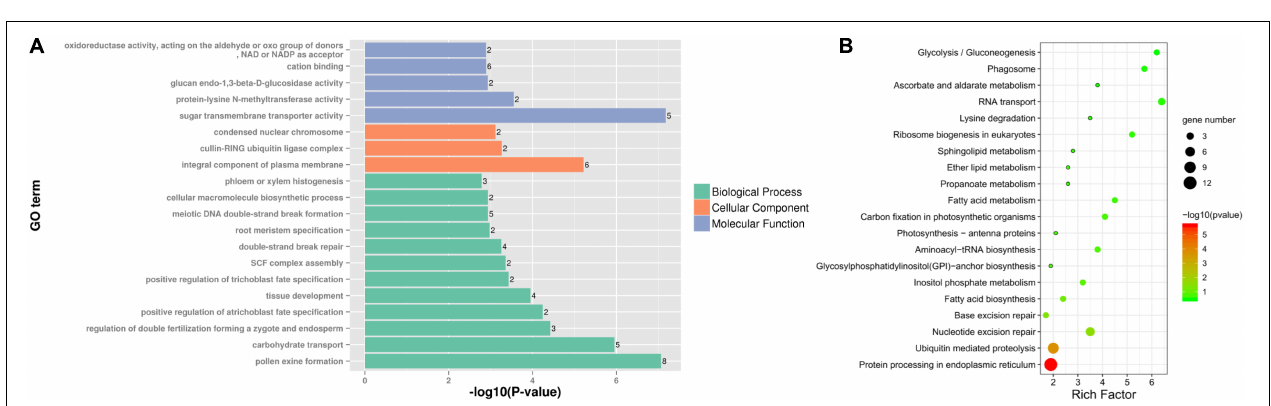
FIGURE 8 | GO and KEGG analyses of differentially expressed genes (DEGs) specific to fertile buds. Enriched (A) GO terms and (B) KEGG pathways of DEGs specific to fertile